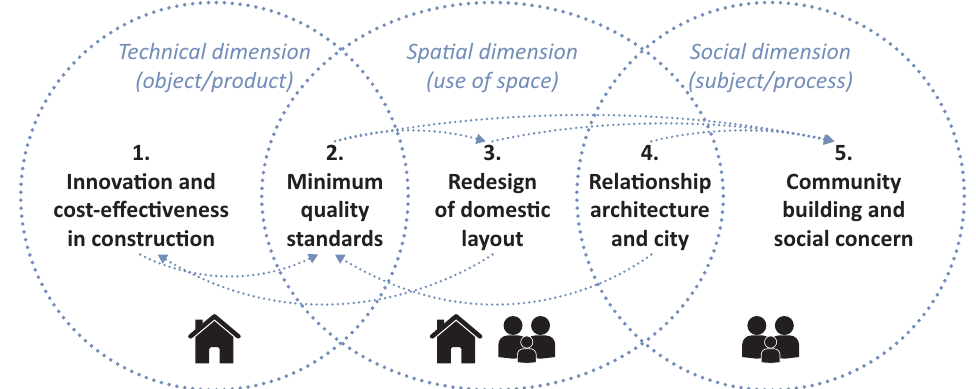
Figure 2. Existenzminimum design principles. Source: author. Urban Planning, 2019, Volume 4, Issue 3, Pages